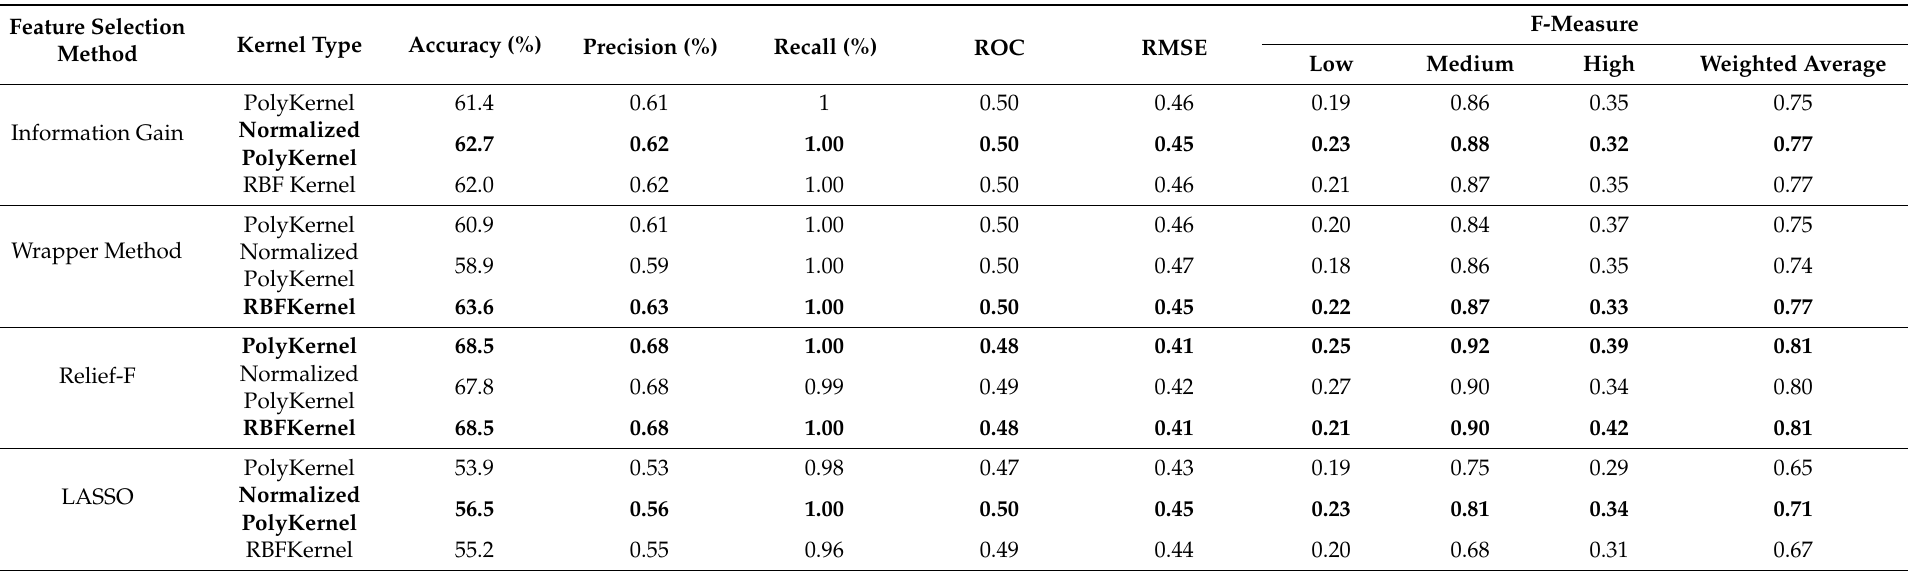
Table 5. Performance of SVM classifier through various feature selection